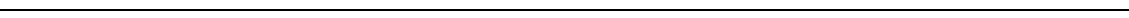
Fig. 3 Assessment of protective ef fi cacy induced by ChAdOx1 ZIKV vaccines. a BALB/c mice ( n = 5) immunised with a single i.m. injection of ChAdOx1 ZIKV vaccines and naive mice were intravenously challenged with 10 5 VP of ZIKA-BR at week 4 after prime. Pre-challenge serum samples were collected for ELISA as shown. b Viral load in ZIKV-challenged groups was monitored for 7 days in sera to follow the onset of viraemia. Each blue line represents one mouse. c Assessment of various parameters of viraemia in groups vaccinated with ChAdOx1 ZIKV vaccines (100% = 6 out of 6 mice). d Pre-challenge reciprocal ELISA titres (Supplementary Fig. 4) were plotted against global ZIKV VL after ZIKV challenge and a comparison was made between ChAdOx1 Env Δ TM versus ChAdOx1 prME Δ TM (left) and ChAdOx1 prME versus ChAdOx1 Env (right). e ELISA OD 450 reads of serially diluted serum samples were plotted to assess the impact of Δ TM in antibody production. Antibody production by ELISA in pre-challenge sera was replicated two times. f Immuno fl uorescence analysis of Vero cells expressing the ZIKV immunogens (green) to assess subcellular staining and distribution. Antigen was detected using a commercial anti- fl avivirus antibody. Blue (DAPI) represents the nucleus and scale bar is 20 μ m. Cell transfections were performed in technical duplicates in two biological replicates. g Kinetics of ZIKV envelope antigen expression in HEK-293 cells by western blot. Antigen was detected using an anti-ZIKV monoclonal antibody in both, non-concentrated supernatant and cell extracts. Red arrows, ZIKV envelope. Actin was used as a loading control. Expression of antigen was veri fi ed in three biological replicates. Uncropped blots are shown in Supplementary Fig.